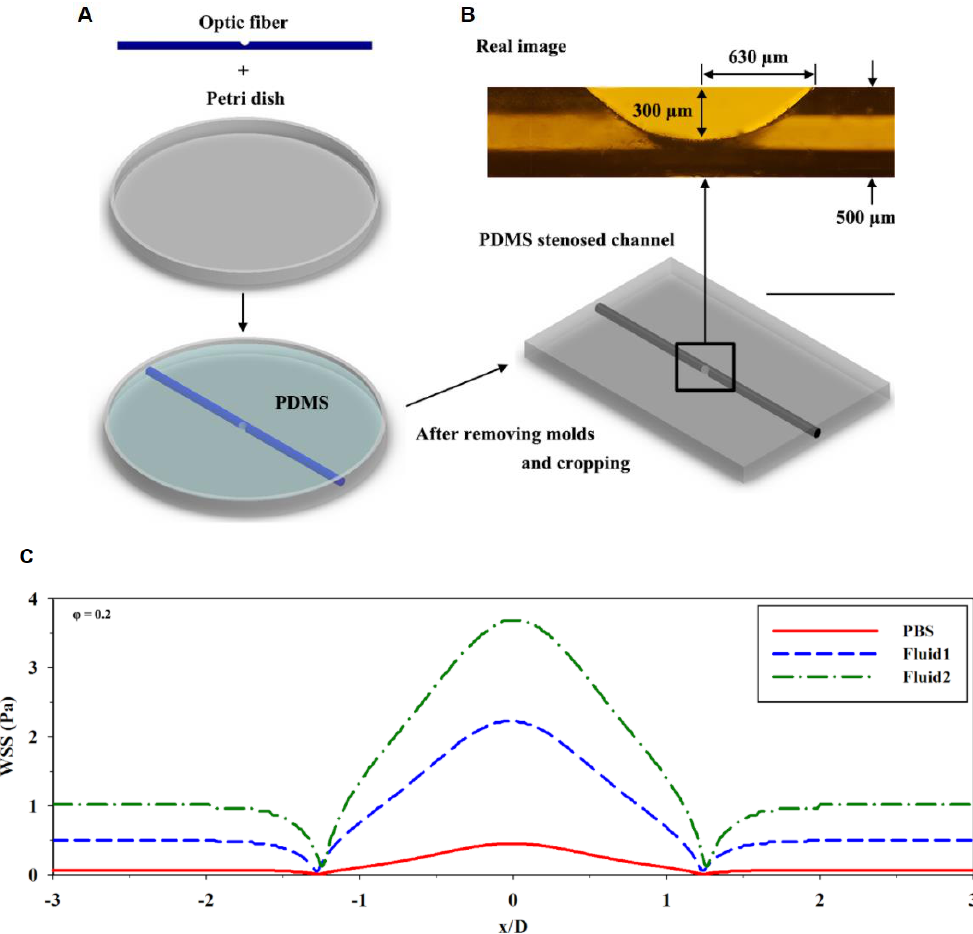
Figure 10. ( A ) Creation of the PDMS stenosed microchannel using a polymethylmethacrylate optic fiber and a petri dish. ( B ) Illustration of the fabricated PDMS stenosed channel (bottom) and actual image (top) captured using a microscope lens. ( C ) the distribution of the Wall Shear Stress (WSS) for the stenosed wall with Phosphate-Bu ff ered Saline (PBS), fluid 1 (consisted of 79.1% ( v / v ) distilled water, 20.9% ( v / v ) glycerol, and 0.21 g / L of xanthan gum for a blood analog fluid [31]), fluid 2 (comprised 0.42 g / L of xanthan gum under the same volumetric ratio of water and glycerol). Adapted from Hong et al.